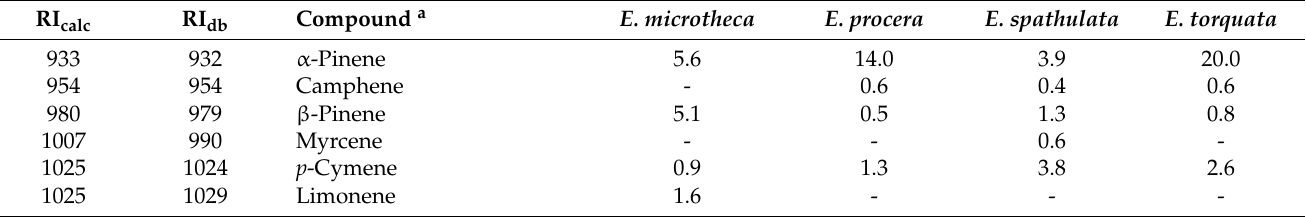
Table 1. Chemical composition (%) of essential oils isolated from leaves of Eucalyptus microtheca , E. procera , E. spatulata , and E. torquata